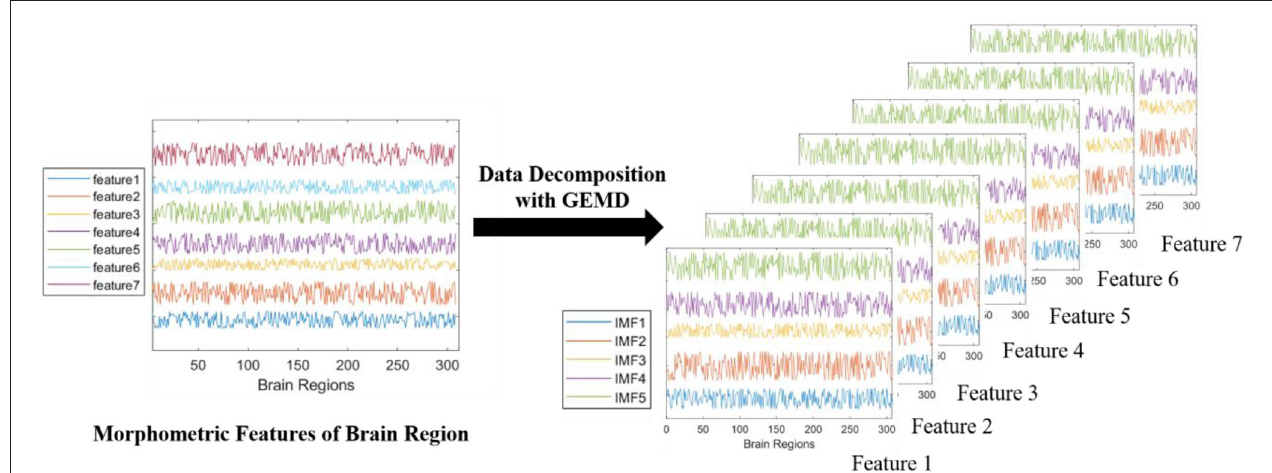
FIGURE 3 | The progress of data decomposition with GEMD. GEMD can decompose feature series (different color lines on the left) into IMFs simultaneously. Here, we use seven morphometric features from MRI data as a decomposition example. Every feature is decomposed into four or five IMFs (different color lines on the right). If only four IMFs are decomposed from raw data, zero-padding will be used to have a total of five IMFs in all the decompositions, so that the data augmentation can proceed successfully.